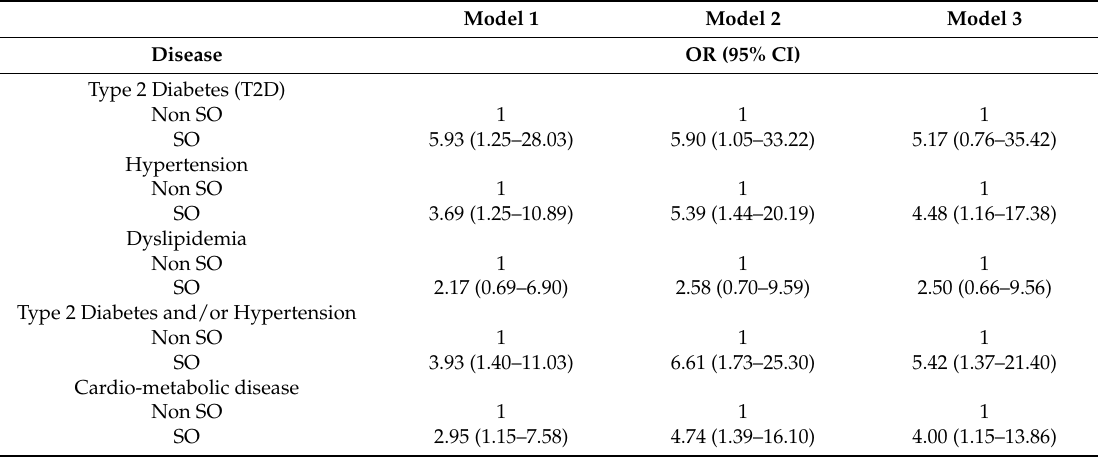
Table 3. Odds of cardio-metabolic disease with sarcopenic